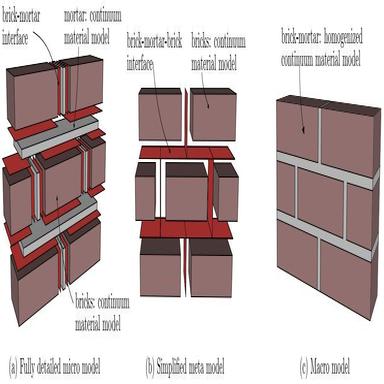
Scales of masonry simulations. Source: Modified from.